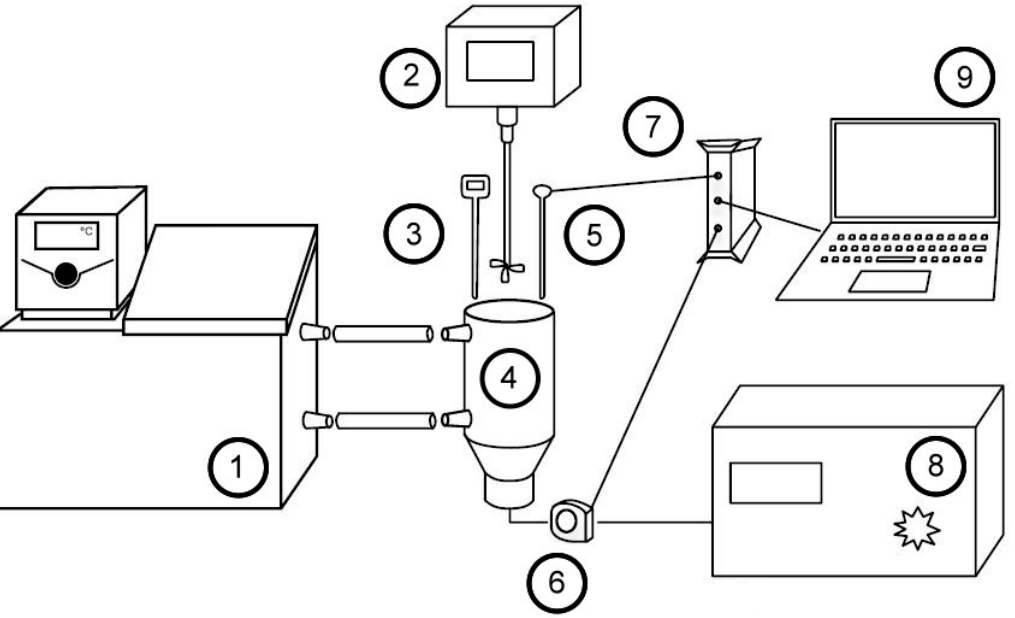
Figure 2. Experimental set-up for ultrasonic upgrading of heavy oil in laboratory